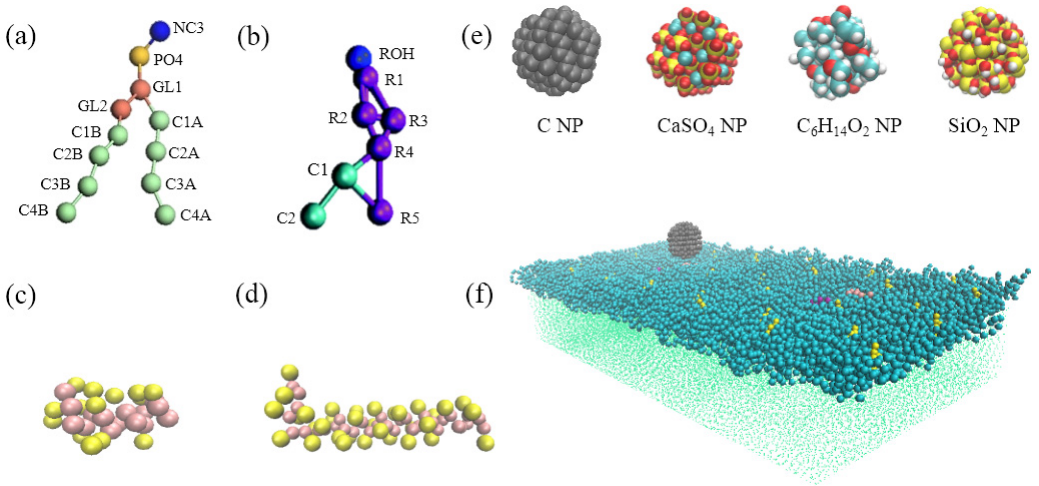
Figure 6. Coarse-grained (CG) models of ( a ) the dipalmitoylphosphatidylcholine (DPPC) molecule; ( b ) cholesterol molecule; ( c ) SP-B protein; ( d ) SP-C protein; ( e ) C, CaSO 4 , C 6 H 14 O 2 , and SiO 2 NPs; and ( f ) NP (cyan)- pulmonary surfactant monolayer with DPPC (blue), cholesterol (yellow), SP-B (purple), SP-C (pink), and water molecules (green).